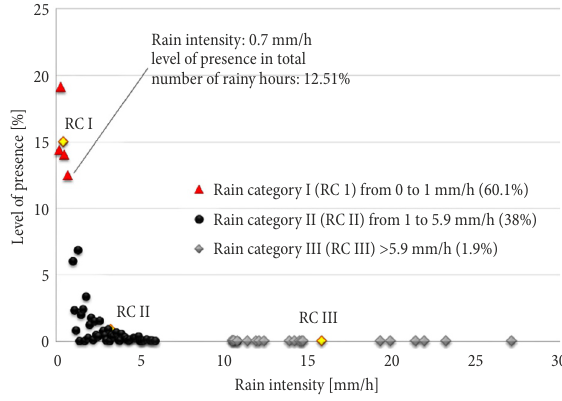
Fig. 1. Rain types classification